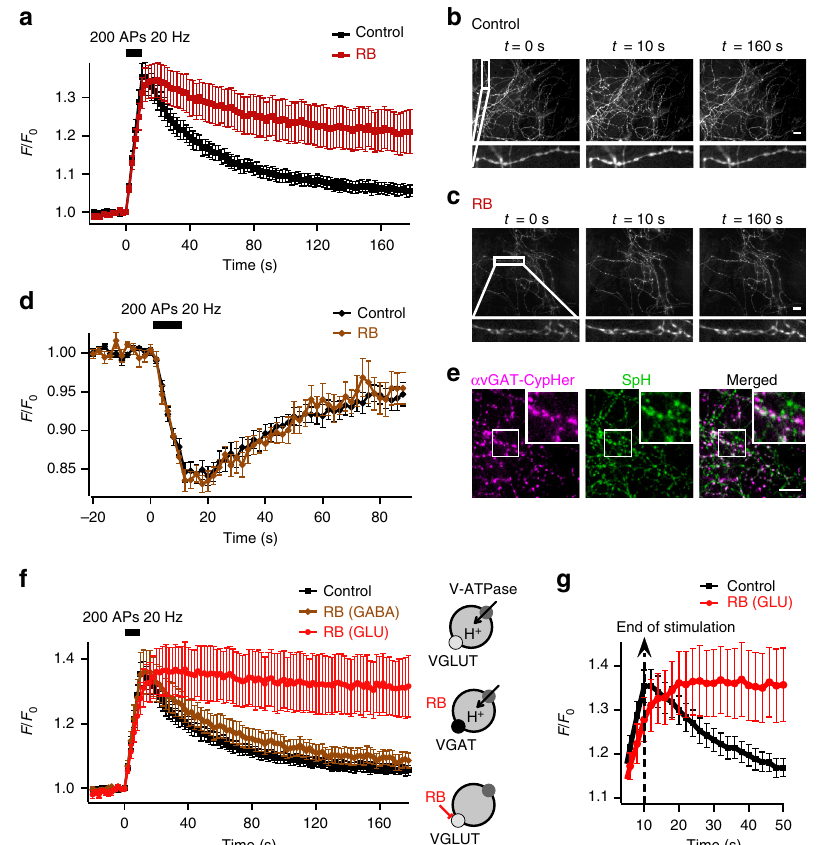
Fig. 1 Inhibition of VGLUT with RB prevents SV re-acidi fi cation. a Average SpH fl uorescence signals in response to 200 action potentials (APs) at 20 Hz with or without RB (100 nM, 5 min) ( n = 24 experiments for each condition). b , c Fluorescence images of hippocampal axonal arborisations expressing SpH in control conditions b or in presence of RB c at various times after the onset of stimulation. d Average α vGAT-cypHer fl uorescence signals in response to stimulation (200 APs 20 Hz) with ( n = 8) or without ( n = 12) RB. e Fluorescence images of SpH-transfected hippocampal neurons labelled with α vGAT- cypHer show partial colocalization with SpH at individual boutons. Scale bars in b – e represent 10 µ m. f Effect of RB on average SpH fl uorescence signals in response to 200 APs at 20 Hz in GABAergic and glutamatergic boutons ( n = 24 for control, 11 for GABAergic boutons with RB, 13 for glutamatergic boutons with RB). g Enlargement of the traces in f at the climax of stimulation. Note the consistent post-stimulus rise in SpH fl uorescence in inhibited glutamatergic boutons due to the sensitivity of inhibited SVs to the activity-dependent transient alkalinisation of the cytosol (Supplementary Fig. 4). The sketches illustrate H + movements. V-ATPase is represented by dark grey- fi lled circles, VGLUT by light grey- fi lled circles and VGAT by a black fi lled circle. Error bars represent